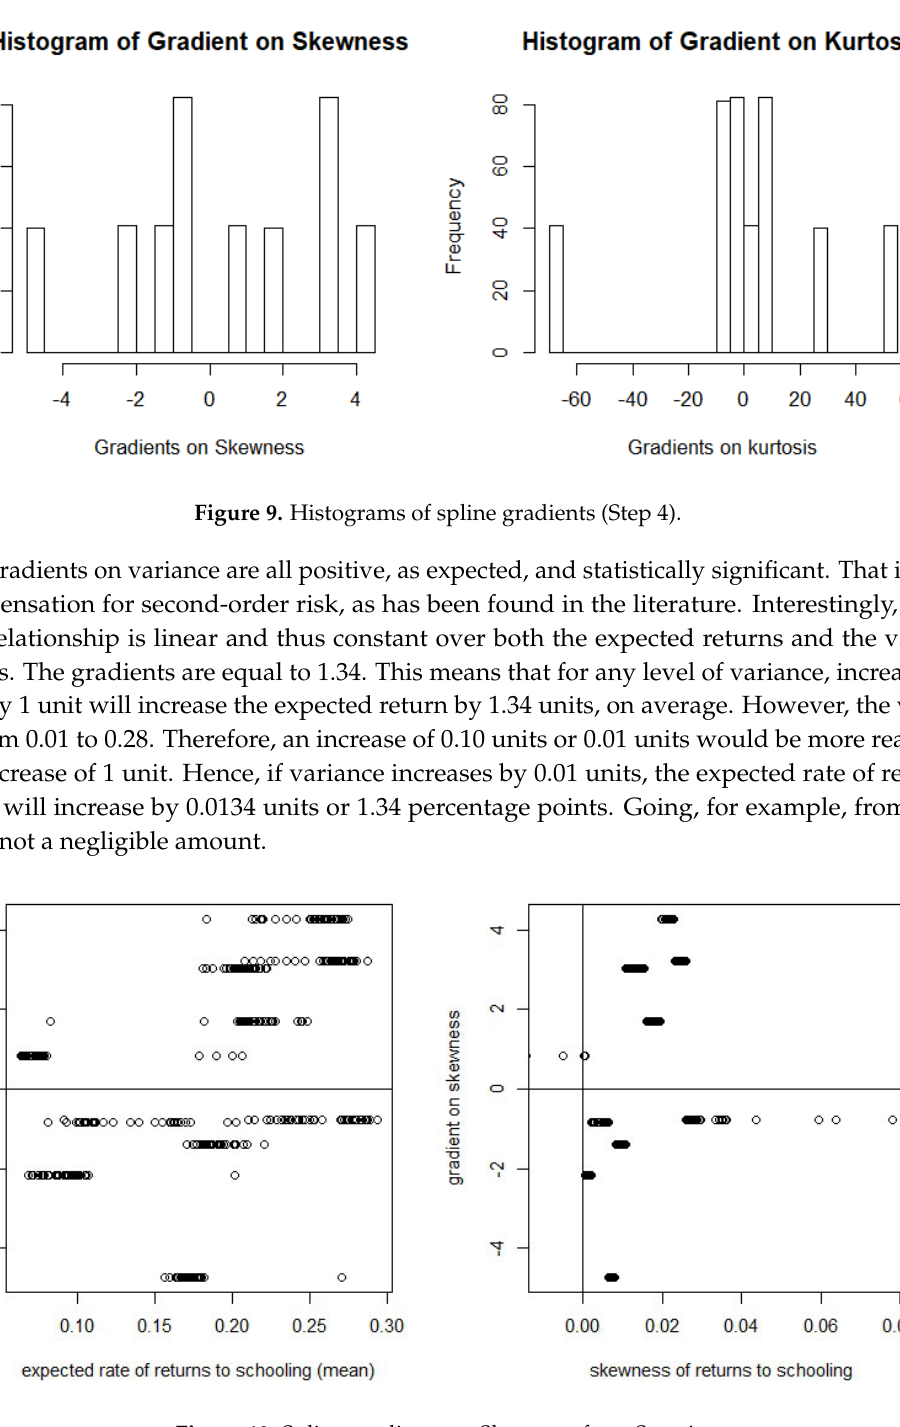
Figure 10. Spline gradients on Skewness from Step